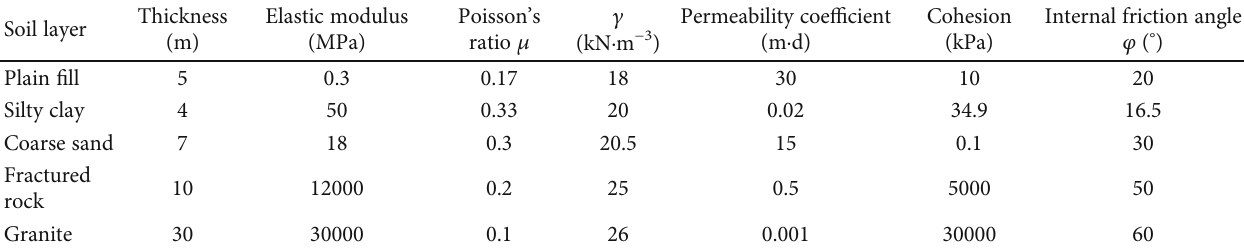
Table 1: Physical and mechanical parameters of surrounded layers.